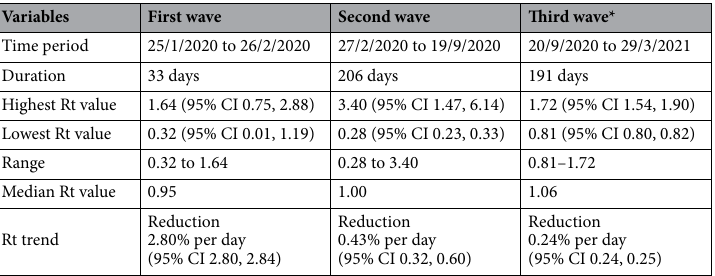
Table 1. Characteristics of estimated Rt across each COVID-19 wave, Malaysia. *Rt estimated by excluding detention cases.